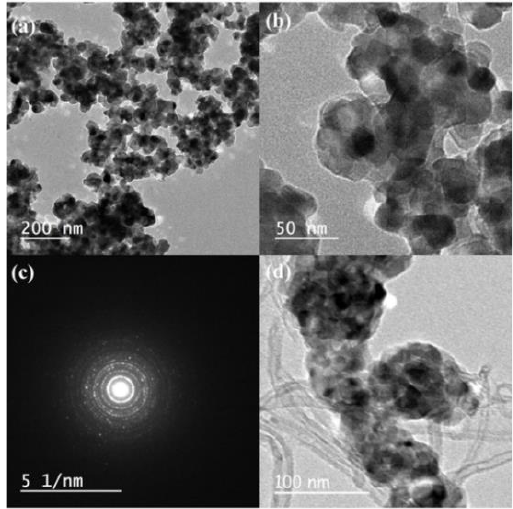
Figure 5. TEM images of ( a , b ) Au@TiO 2 with 8.14% Au; ( c ) selected area electron diffraction pattern; ( d ) TEM image of Au@TiO 2 /MWCNTs composite